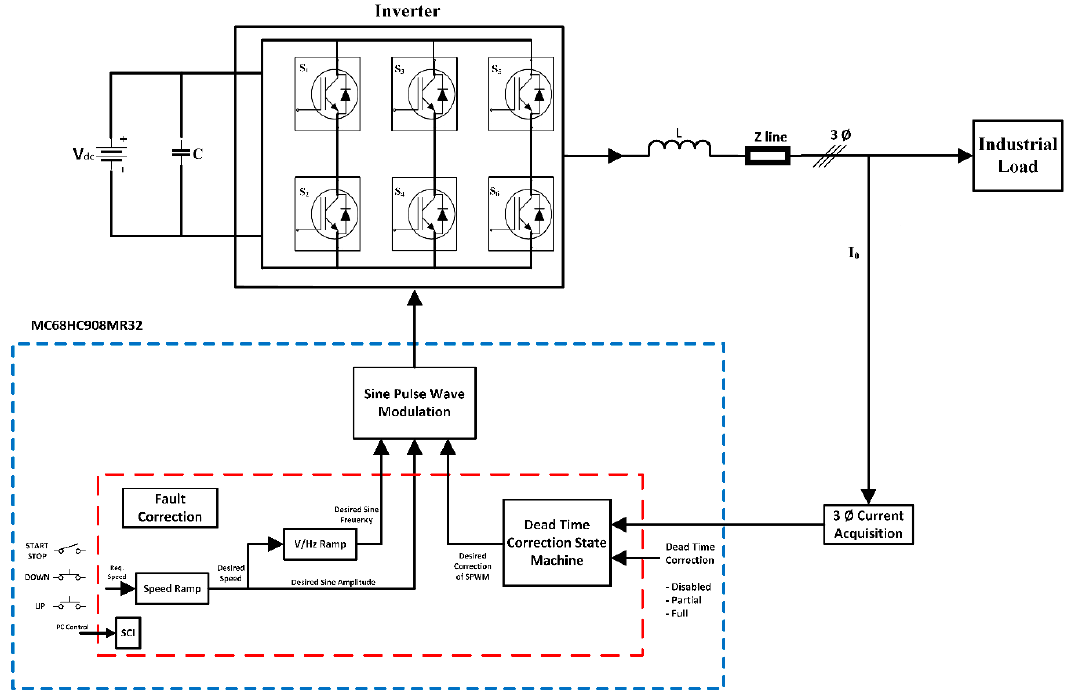
Figure 2. Model structure with dead-time compensation.